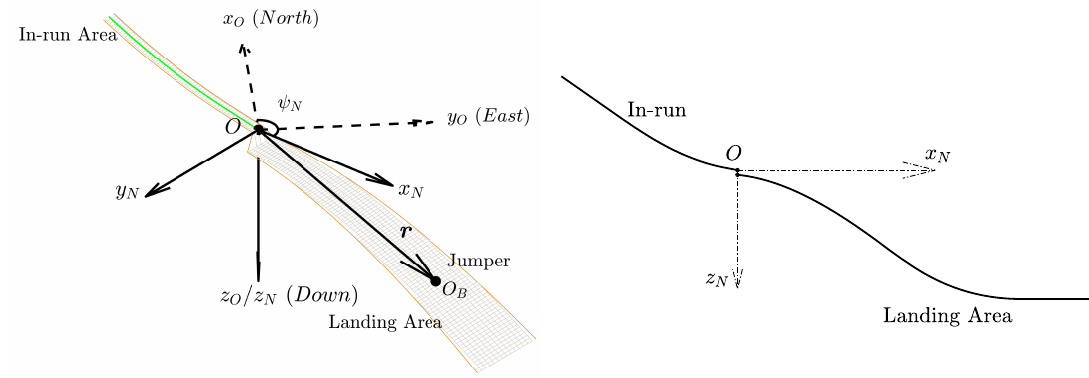
Figure 2. Definitions of the local north-east-down frame and the hill reference frame.